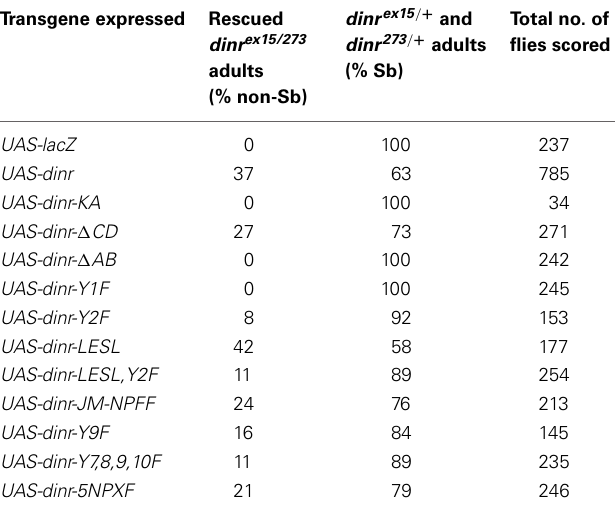
Table 1 | Rescue of adult lethality by DInR